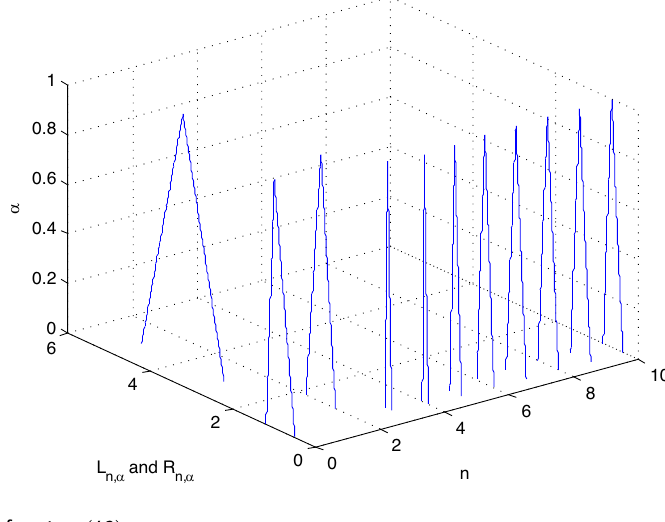
Figure 1: The dynamics of system ( 42 )